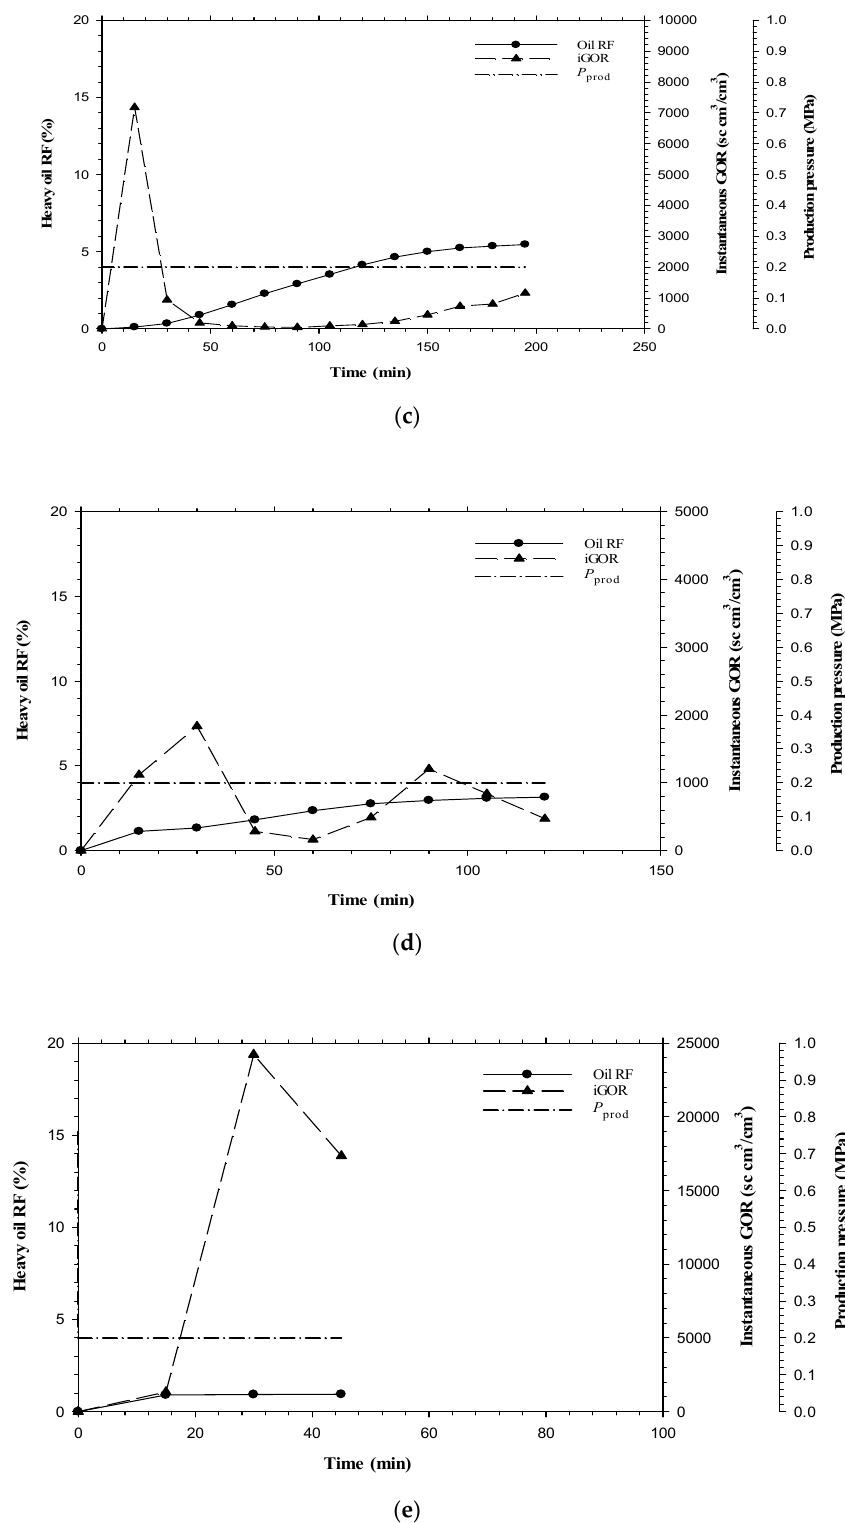
Figure 7. Measured heavy oil recovery factors (RFs), instantaneous gas-oil ratios (iGORs), and production pressures ( P prod ) in C 3 H 8 -GPC process at ∆ P EOR = 0.5 MPa (Test #4) ( a ) Cycle #1; ( b ) Cycle #2; ( c ) Cycle #3; ( d ) Cycle #4; and ( e ) Cycle #5.